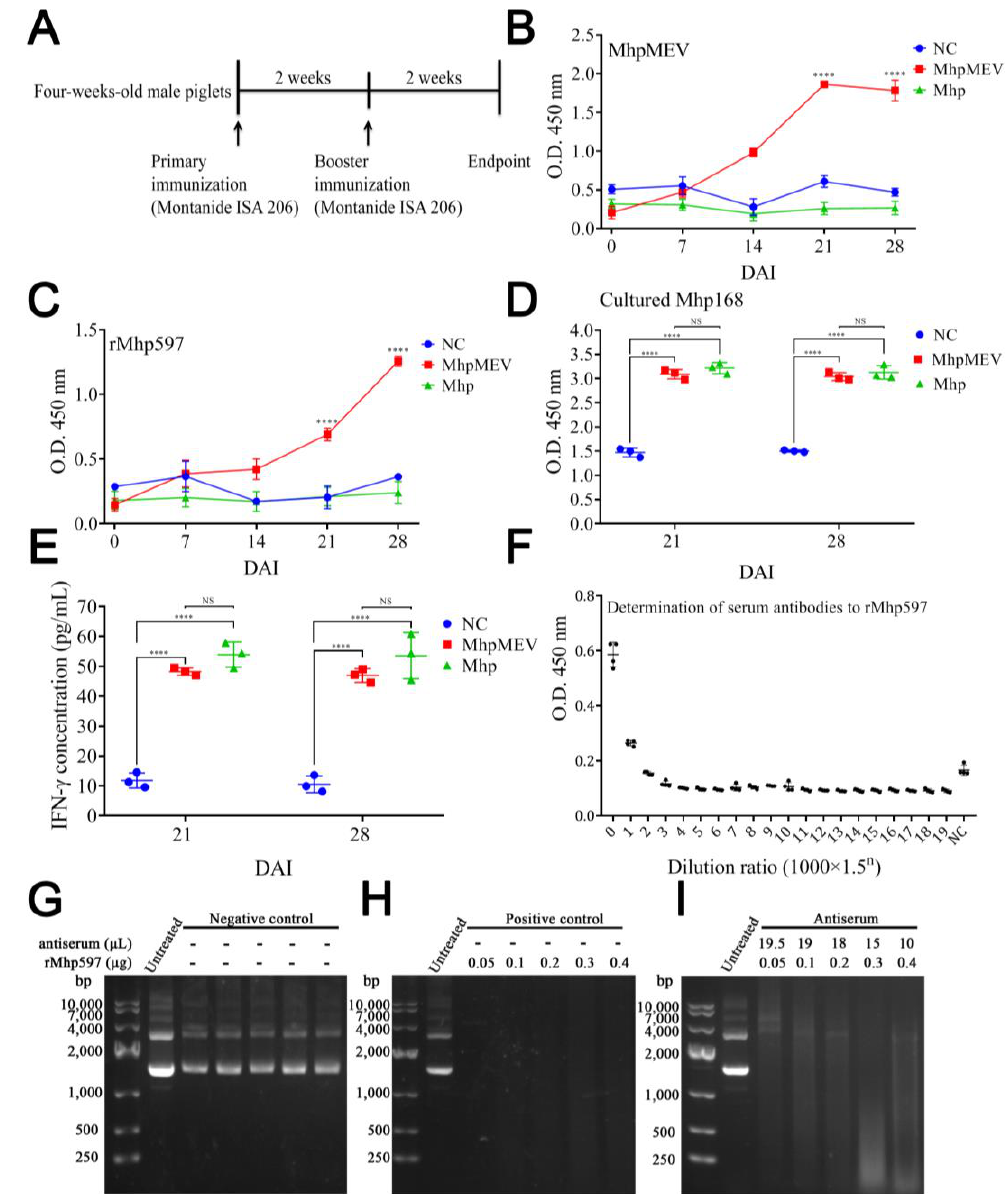
Figure 8. Immunoassay results of piglet immune experiment. ( A ) The vaccination schedule of the piglet immune experiment. ( B ) Serum ELISA results against MhpMEV. ( C ) Serum ELISA results against rMhp597. The symbol **** indicates a statistical difference between the MhpMEV group and the NC group at 21 or 28 d. ( D ) Serum ELISA results against cultured Mhp168 strain at 21 and 28 d. ( E ) Serum IFN- γ levels determined by indirect ELISA at 21 and 28 d. ( F ) Determination of Mhp597 antibody titer in serum at 28 d. Electrophoresis results of different groups of antiserum on the inhibition of rMhp597 nuclease activity are presented in ( G – I ), respectively. The concentrations of rMhp597 in reaction are indicated, while the concentrations of antiserum were the opposite. All data are presented as means ± standard deviation; unpaired t test with Holm–Sidak adjustment was used for significance analysis, **** p < 0.0001, NS,